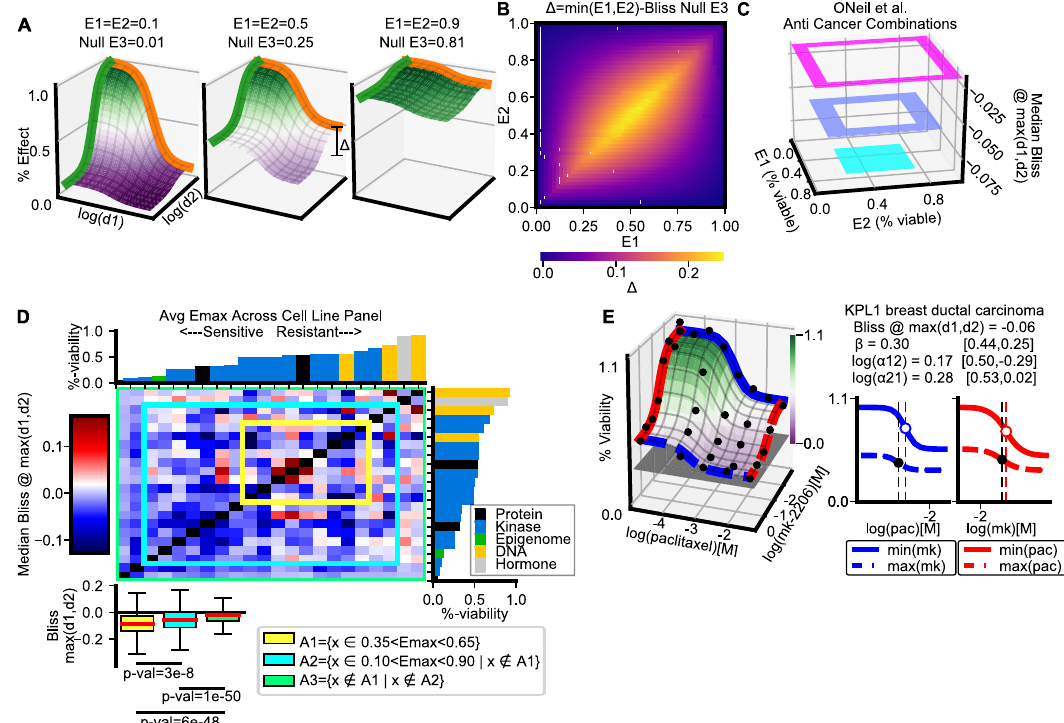
Fig. 4 Bliss is biased against combinations of moderately ef fi cacious drugs. A The null dose-response surface according to Bliss such that Bliss is zero at all doses for different single agent ef fi cacy. Δ is de fi ned as the expected increase in percent effect of the combination over the stronger single agent at saturating doses. The left and right panels have the same expected increase according to Bliss, Δ = 0.09, while the combination of moderately ef fi cacious drugs (middle panel) has a expected increase of Δ = 0.25. The color of the surface indicates the drug combination effect, from no effect (green) to maximum (purple). The solid color lines on the left and back sides show the single-drug responses. B Calculation of Δ (colorbar bottom) for surfaces with different pairings of ( E 1, E 2). Color indicates the difference, with range given on the colorbar below the image. C Median Bliss for anti-cancer combinations 26 grouped by the maximal ef fi cacy of their single agents. Ranges for each square: cyan square: [0.35, 0.65], blue square: [0.1, 0.9], and magenta square: [0.0, 1.0]. Bliss is calculated at the maximum tested concentrations of both drugs. D Heatmap of the median Bliss score (colorbar left) for each combination across the cancer cell-line panel 26 . Rows and columns are ordered by the average ef fi cacy of each drug alone over all cell-lines ( E max ) (bar graphs top and right). Colored boxes correspond to groupings denoted in the legend (bottom). Boxplots show Bliss trends toward antagonism for combinations of moderately ef fi cacious drugs (assuming approximate normality, one-sided t -test, blue < yellow;green < blue;green < yellow). The bottom and top of the boxes are the fi rst and third quartiles, respectively. The red line shows the median. The whiskers extend to 1.5 times the interquartile range below and above the fi rst and third quartiles. The boxplots represent n = 967 biologically independent combinations (yellow), n = 6047 combinations (cyan), and n = 7773 combinations (green). E Dose-response surface of paclitaxel and mk-2206 in KPL1 cells 26 . Gray plane is the expected effect of the combination by Bliss at